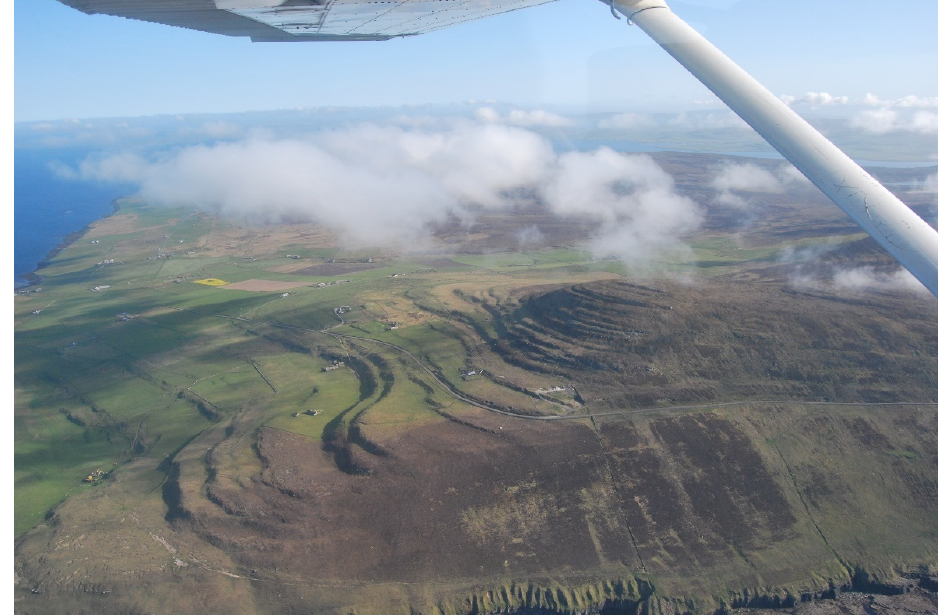
Figure 1. Looking southeast across Sourin, Rousay, the sharp relief of the topography is clearly visible and highlights the challenges of crossing the centre of the island. © James Moore.